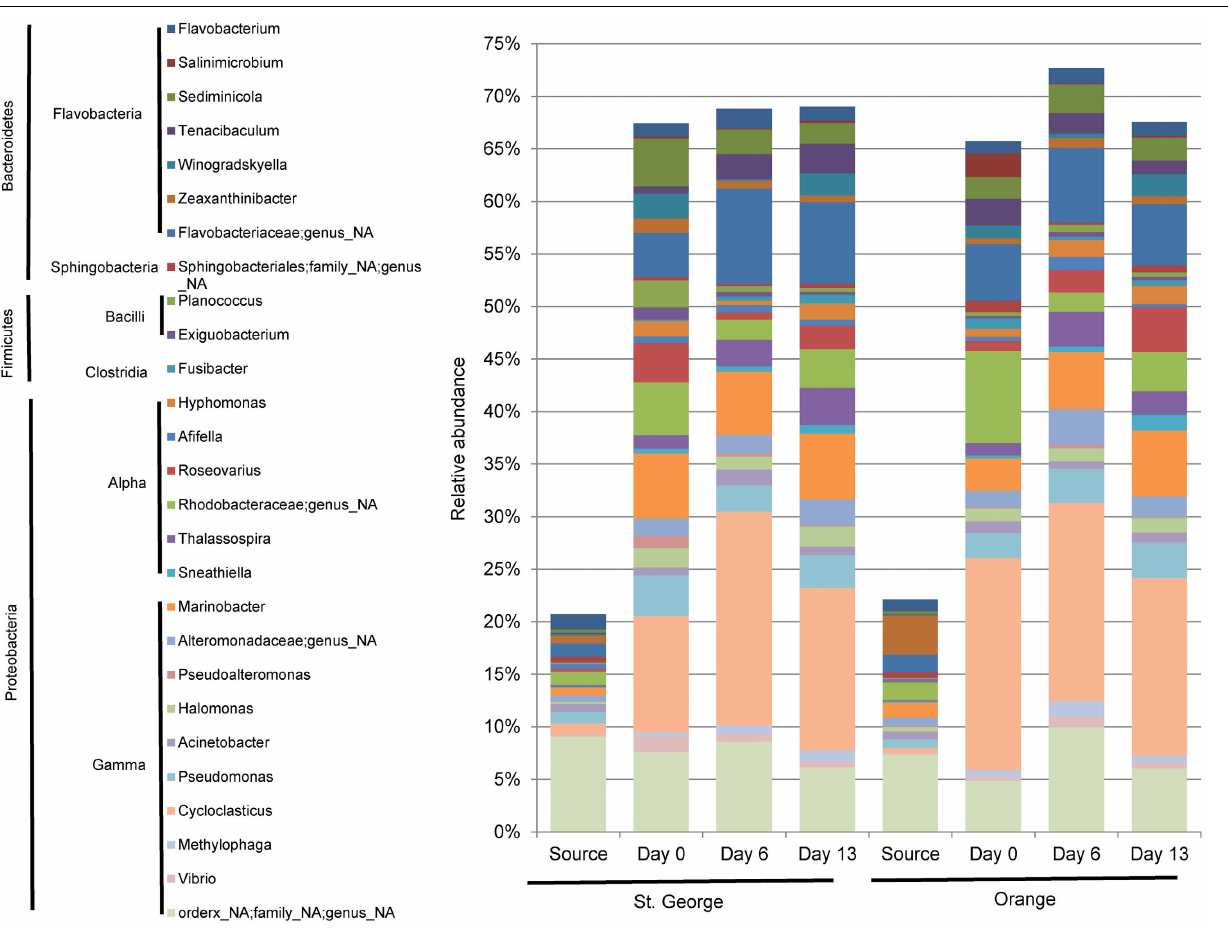
FIGURE 4 | Taxonomic representation of source and mesocosm column sand samples, assigned from the 16S rRNA gene sequencing data. Genera (and un-resolved genera) composing ≥ 1% of the community at any time (day 0, 6, or 13) within any mesocosm (average of the 2 experimental columns) spiked with PAHs are represented. Source represents the population